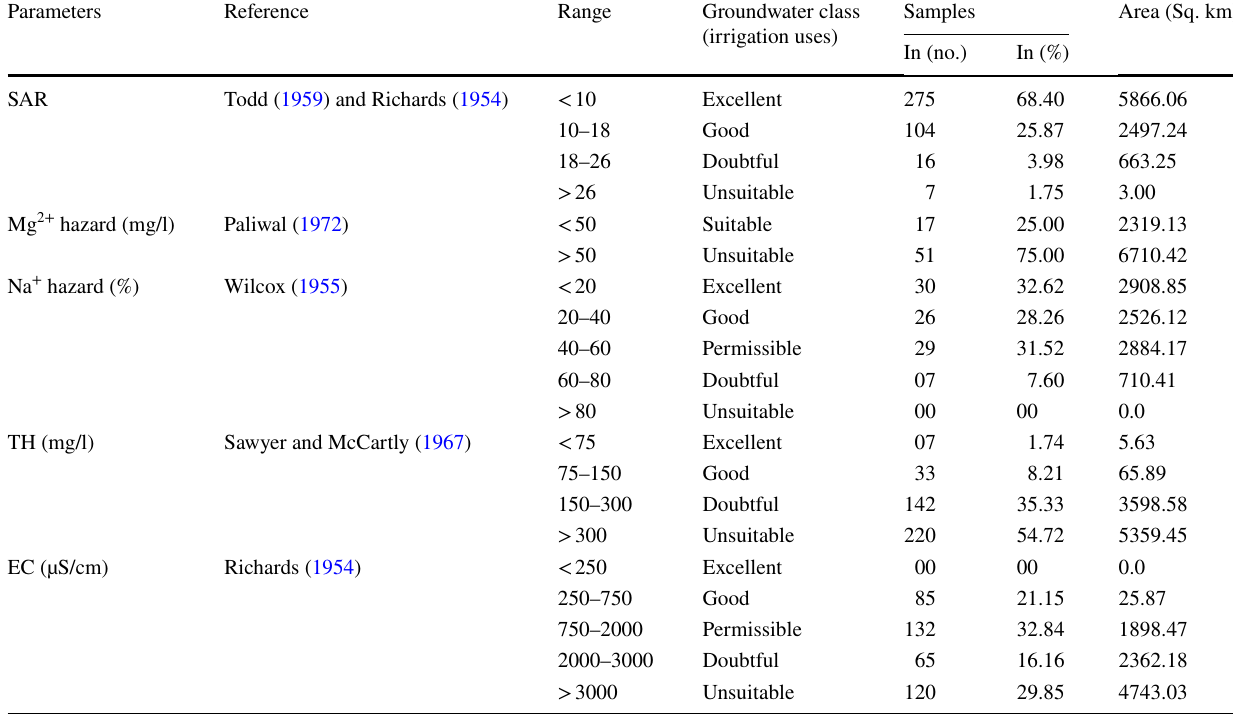
Table 6 Irrigational quality parameters results in groundwater sample